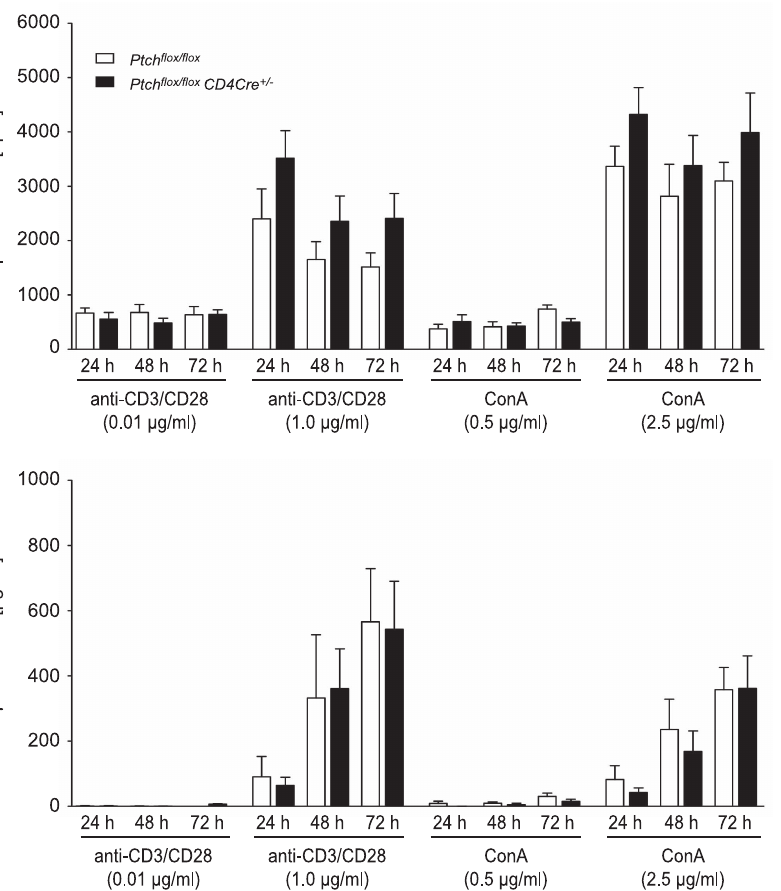
Figure 3. Proliferation and IFN c production by activated T cells. Total T cells were isolated from the spleens of Ptch flox/flox control or Ptch flox/ flox CD4Cre + / 2 mutant mice and 10 5 cells per well were stimulated with different concentrations of ConA or anti-CD3/CD28 antibodies in a total volume of 200 m l medium. For detection of IFN c , 50 m l medium were removed at each time point and used for analysis by ELISA. For measurement of proliferation, an equal volume of fresh medium containing 37 kBq 3 H-thymidine was added to the same wells and incubated for another 16 hours. (A) Proliferation was assessed by scintillation counting. (B) Quantification of IFN c levels was achieved by ELISA. Each panel shows the mean 6 SEM of five individual experiments. Statistical analysis for each experimental condition was performed by unpaired t-test and no differences were found in any case.